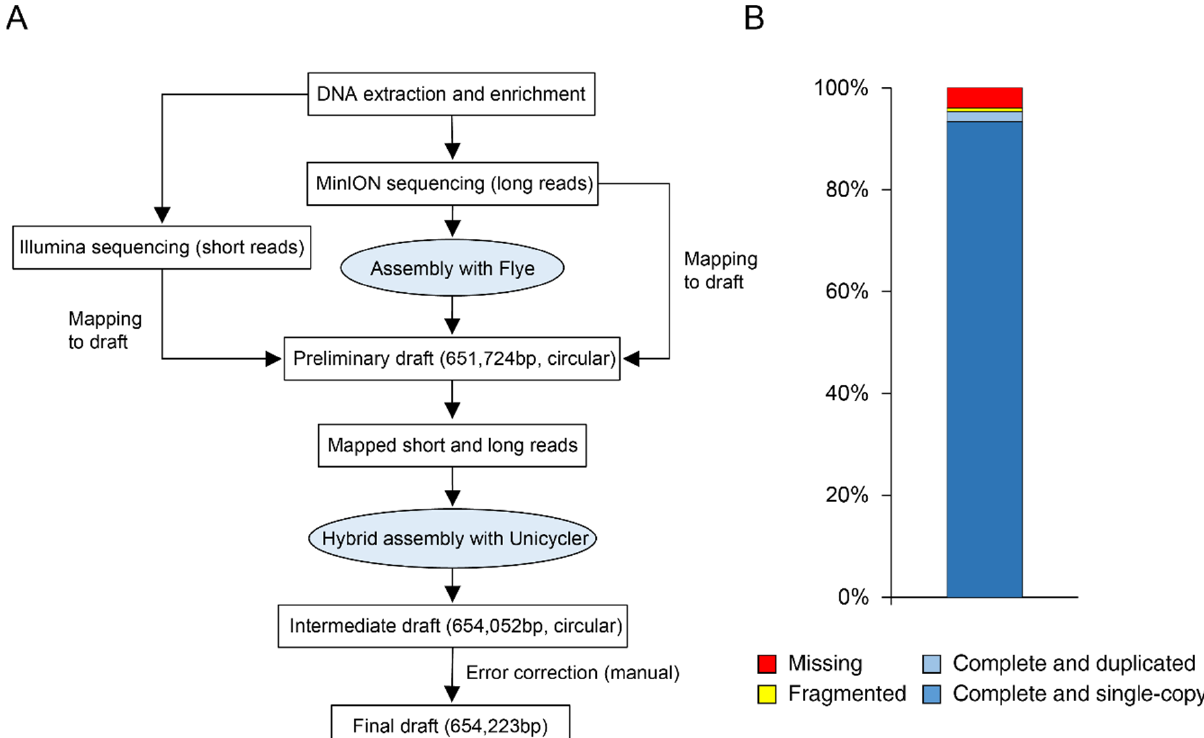
Figure 1. Genome assembly and quality assessment. ( A ) Workflow proposed as the successful approach for de novo genome assembly. ( B ) BUSCO analysis to assess completeness of the assembled chromosome.